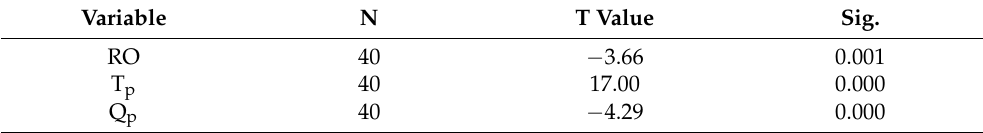
Table 3. Effects of the GLC on hydrological variables based on paired T-tests. Variable